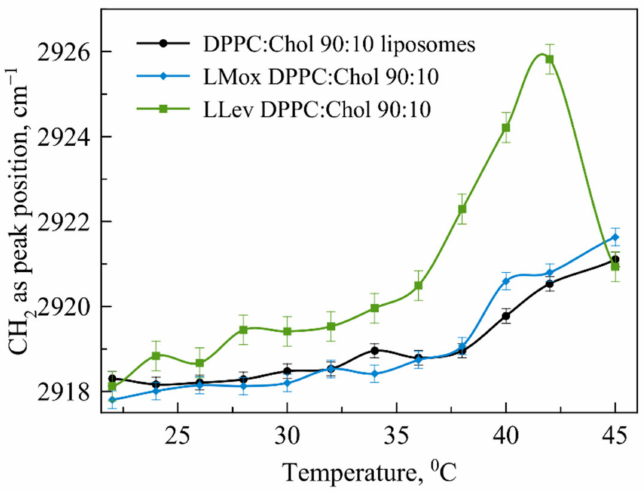
Figure 5. Dependence of wavenumber of ν CH 2 as peak position on the temperature for DPPC:Chol 90:10 liposomes (black line), LMox DPPC:Chol 90:10 (blue line) and LLev DPPC:Chol 90:10 (green line). For each point SD is presented ( n = 3). Total lipid concentration 5 mg/mL. 0.02 M Na phosphate- buffered solution, pH